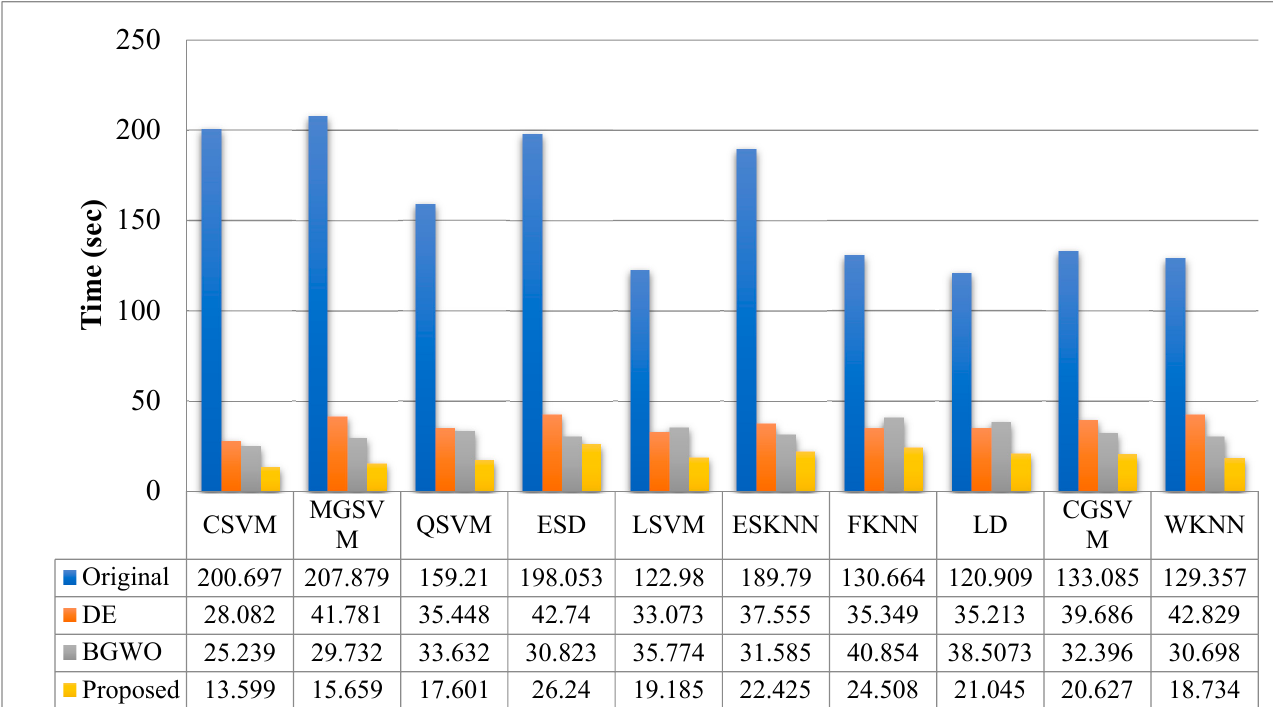
Figure 12. Confusion matrix of Cubic SVM after the proposed feature fusion approach.